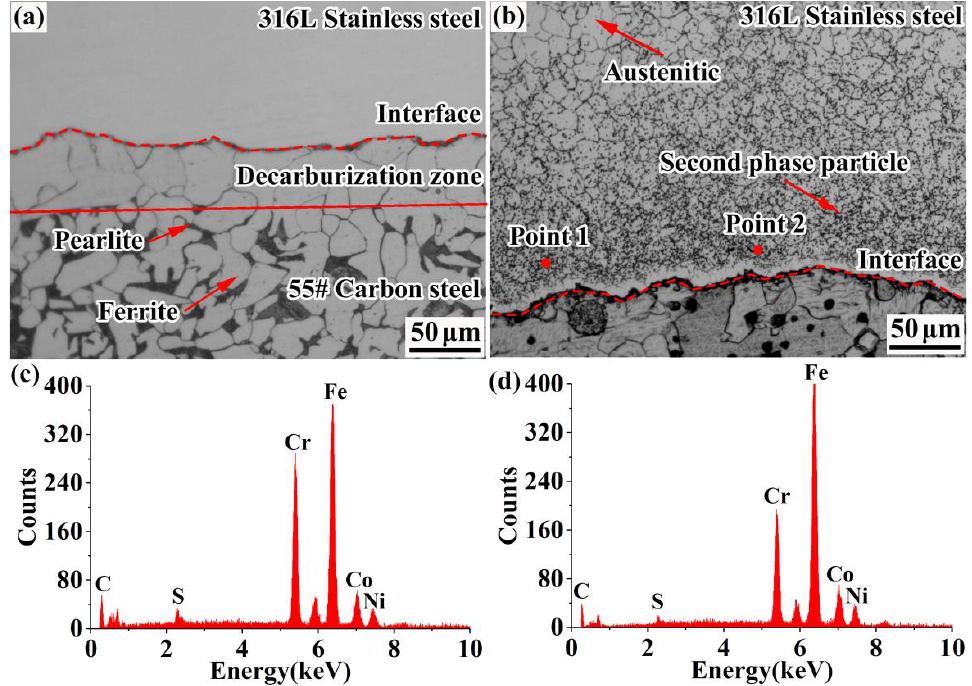
Figure 4. Metallographic images of the rebar composite interface: ( a ) carbon-steel side, ( b ) stainless-steel side, ( c ) element distribution at point one, and ( d ) element distribution at point two.